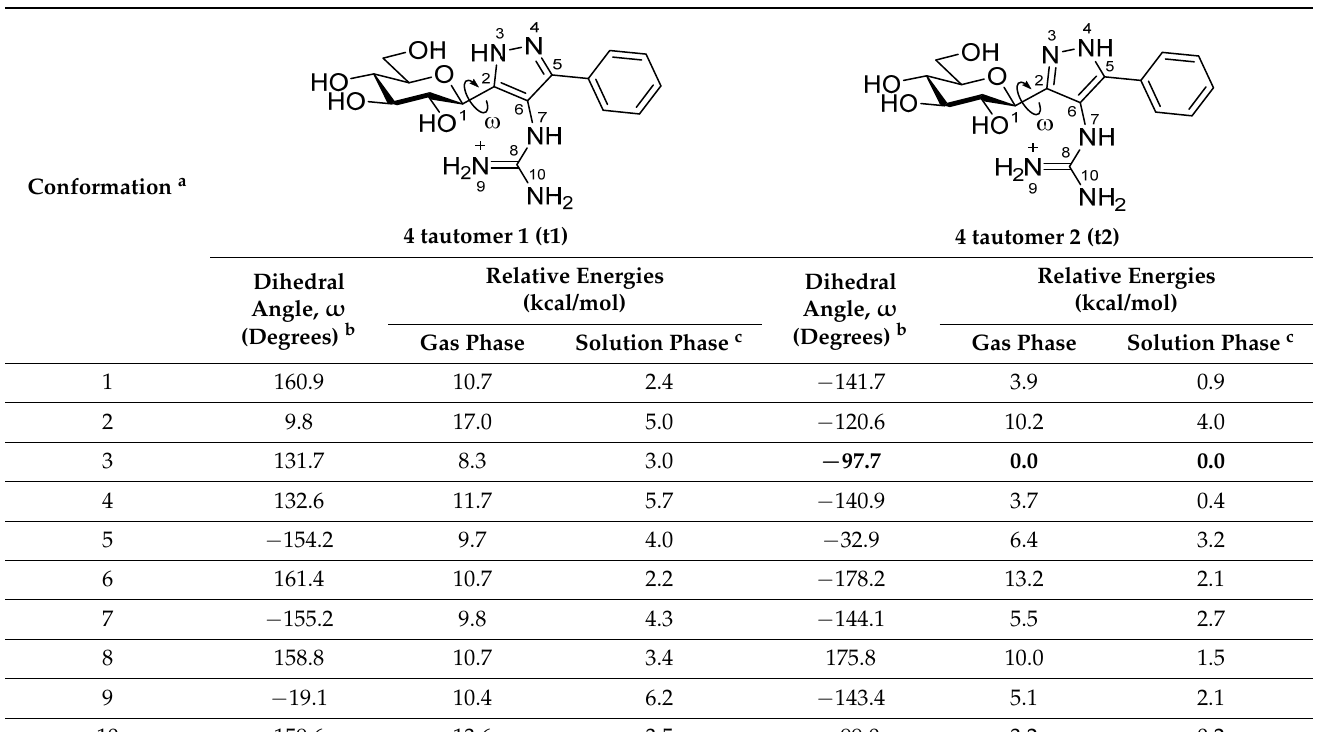
Table 4. Relative energies (kcal/mol) of the predicted conformations of compound 4 tautomers t1 and t2 calculated using DFT at the M06-2X/6-31+G* level of theory (gas phase), with water solvation effects additionally accounted for with the SM8 model (solution phase). The most stable calculated state of the compound is highlighted in bold for each phase.